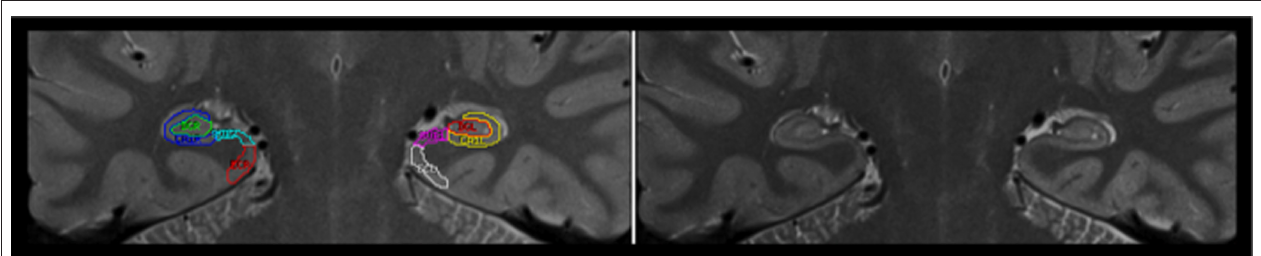
Figure 1 | example of hippocampal subfields tracing. A starting slice with (left side) and without (right side) tracing is shown.